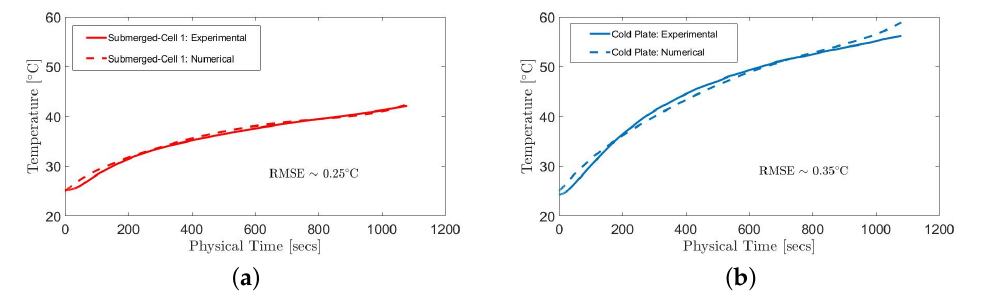
Figure 5. Comparison between experiments and 3D CFD simulations as published in [7] with corresponding root mean square error (RMSE) for, ( a ) immersion cooling, and ( b ) cold-plate